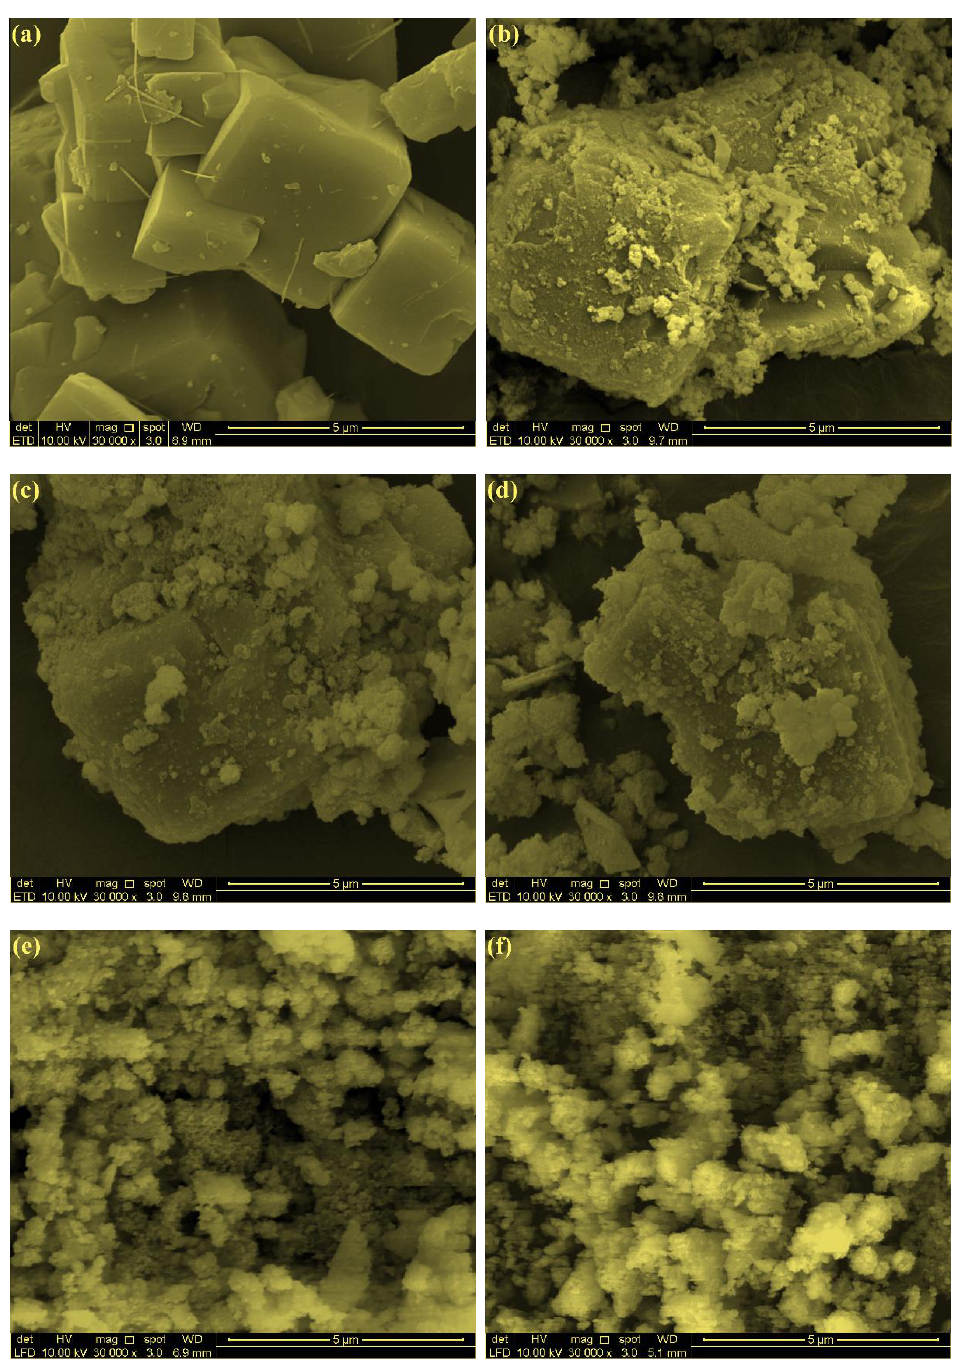
Figure 4. FESEM images of zeolite ( a ), FeZ-1.5 ( b ), FeZ-3 ( c ), FeZ-5 ( d ), FeZ-8 ( e ), and FeZ-10 ( f ) composites.